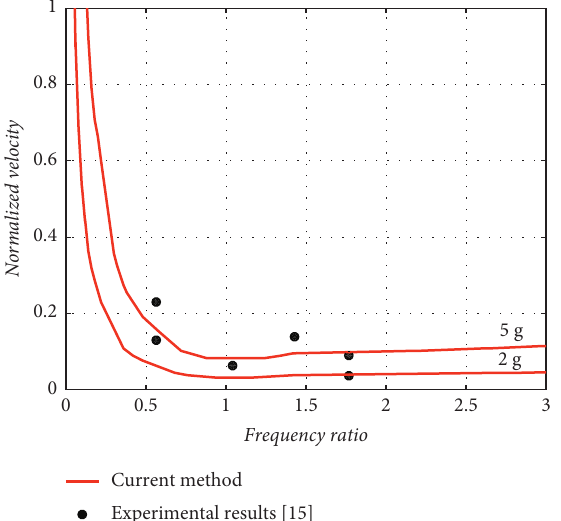
Figure 7: DDBCs of a packaging system with hyperbolic tangent stiffness predicted by the proposed method and Runge-Kutta method at 2 g 5 g and 10 g